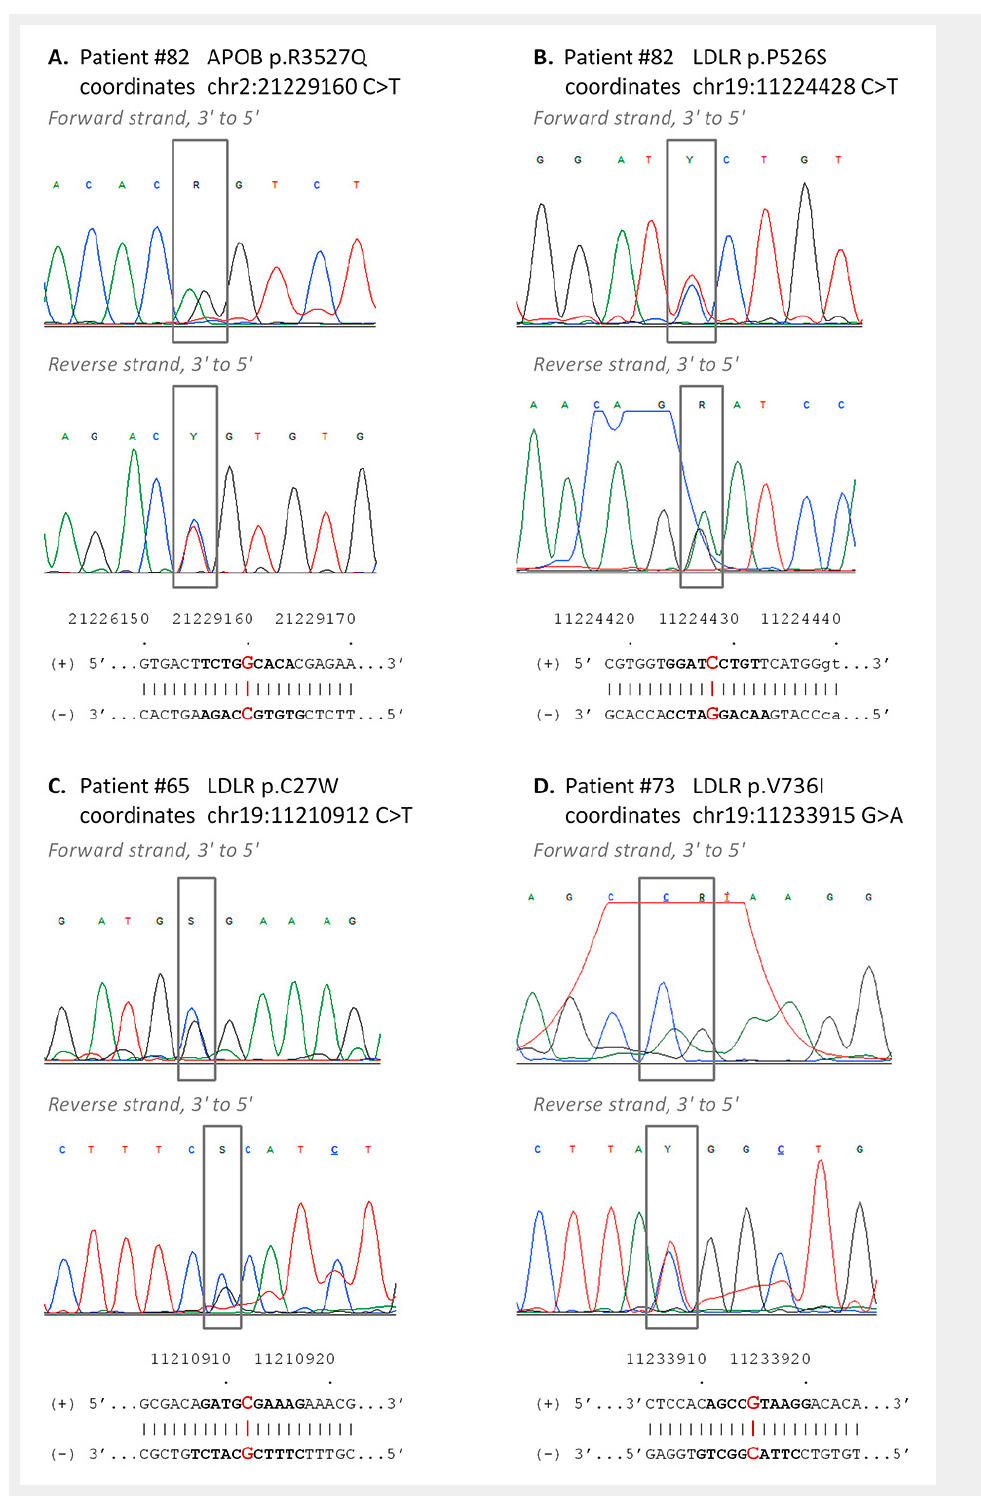
Figure 5 Confirmatory Sanger sequencing. The most clinically relevant variants of patients 82 (A, B), 65 (C) and 73 (D) were confirmed by bidirectional Sanger sequencing. Each panel shows chromatograms of the forward (top) and reverse (bottom) sequencing reactions, together with the corresponding reference sequences on the (+) and (–) strands (hg19). The variants are boxed in grey on the chromatograms; the corresponding positions on the reference sequence are highlighted in red; the stretch of reference sequence shown in the respective chromatograms is in bold letters. APOB is coded by the (-) strand, LDLR is coded by the (+)